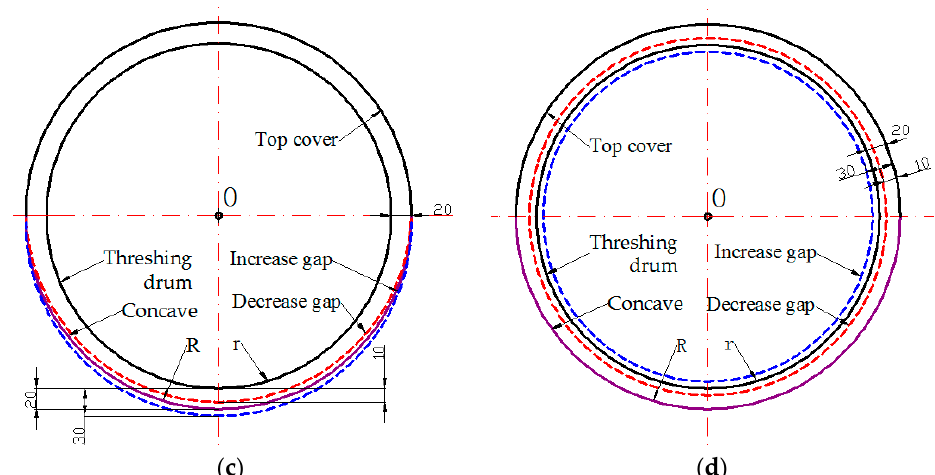
Figure 1. Two threshing gap adjustment types: ( a ) Concave adjustment type; ( b ) Threshing drum adjustment type; ( c ) Cross section of concave adjustment type; ( d ) Cross section of threshing drum adjustment type.